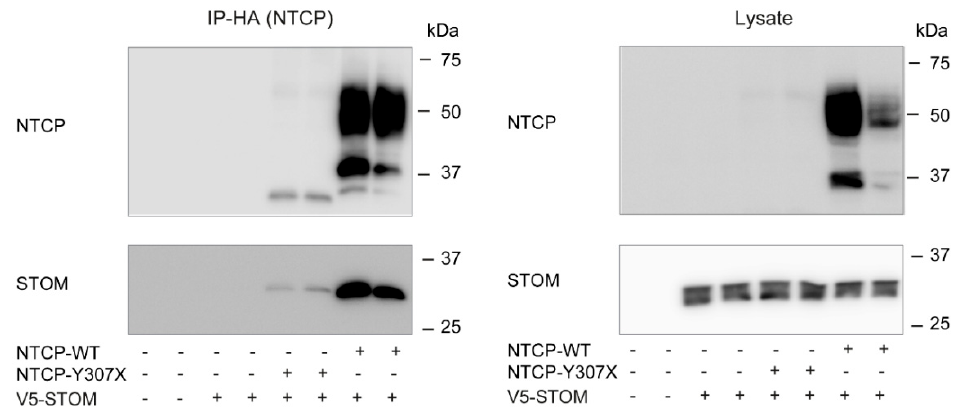
Figure 6. NTCP lacking its C-terminus can still interact with stomatin. Immunoprecipitation of HA-hNTCP-WT or HA-hNTCP-Y307X upon transient overexpression in U2OS stably expressing stomatin (Stom-V5). Representative western blot of two independent experiments.